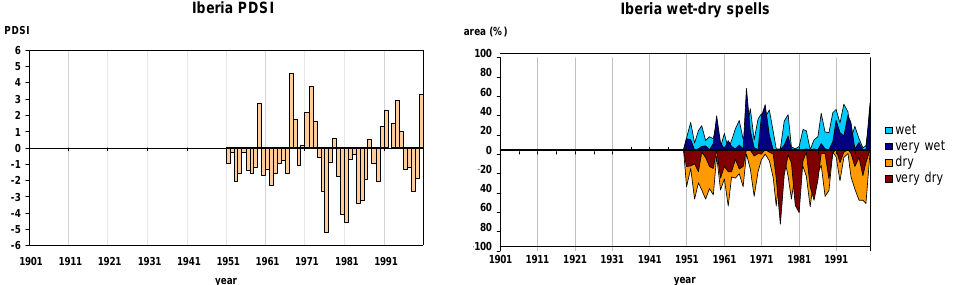
Fig. 6. (left) Inter-annual variability of PDSI for the Iberia region; (right) corresponding percentages of area under wet (blues) and dry (yellows)